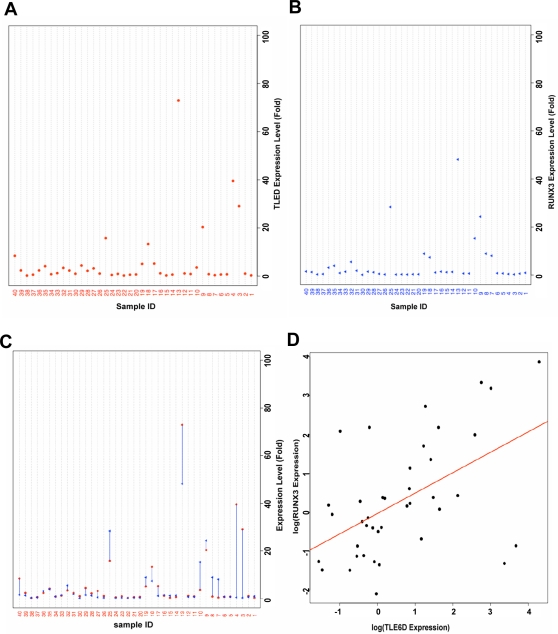
TLE6D and RUNX3 mRNA expression levels in human colorectal cancers.(A,B) Dotplots of TLE6D and RUNX3 expression levels for each of the 40 samples. Expression is shown as fold elevation vs. accompanying normal adjacent mucosa. (C) Superimposed plot of TLE6D and RUNX3 expression levels by sample (Pearson correlation 0.724; Pvalue<0.001). (D) A scatterplot of log-transformed RUNX3 by TLE6D expression levels along with the least squares estimate of the regression of RUNX3 on TLE6D. Expression levels were log-transformed in the regression analysis due to heavy skewness. Based upon the regression, it was estimated that the geometric mean of RUNX3 expression increased 0.525 with a 2-fold increase in TLE6D expression (95% CI: 0.165, 0.563; p Value<0.001).